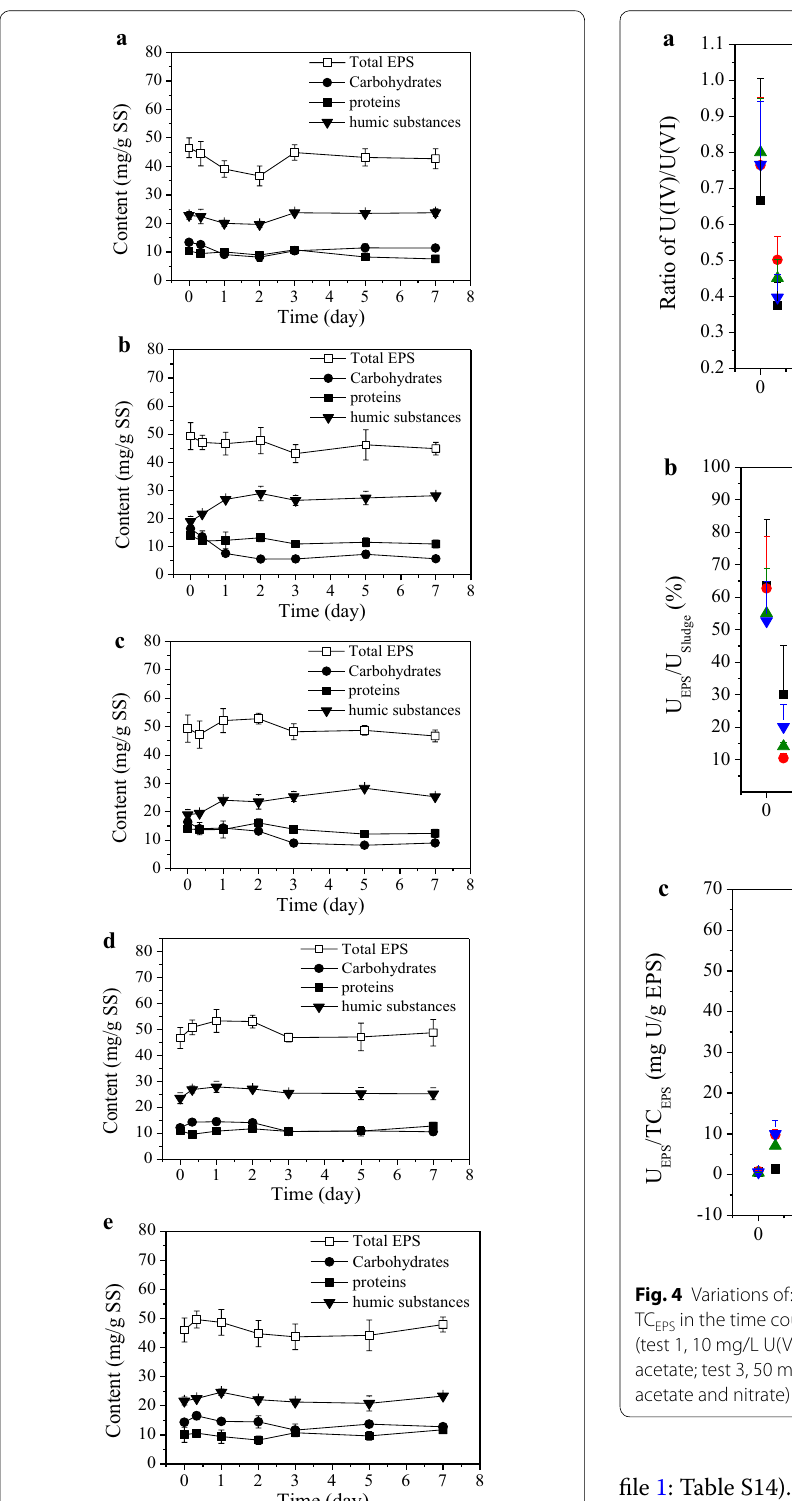
file 1: Table S14). Riboflavin was also found in EPS (Addi- tional file 1: Figure S6). The transformation of U in EPS after reoxidation was also analyzed (Additional file 1: Figure S4c, d and